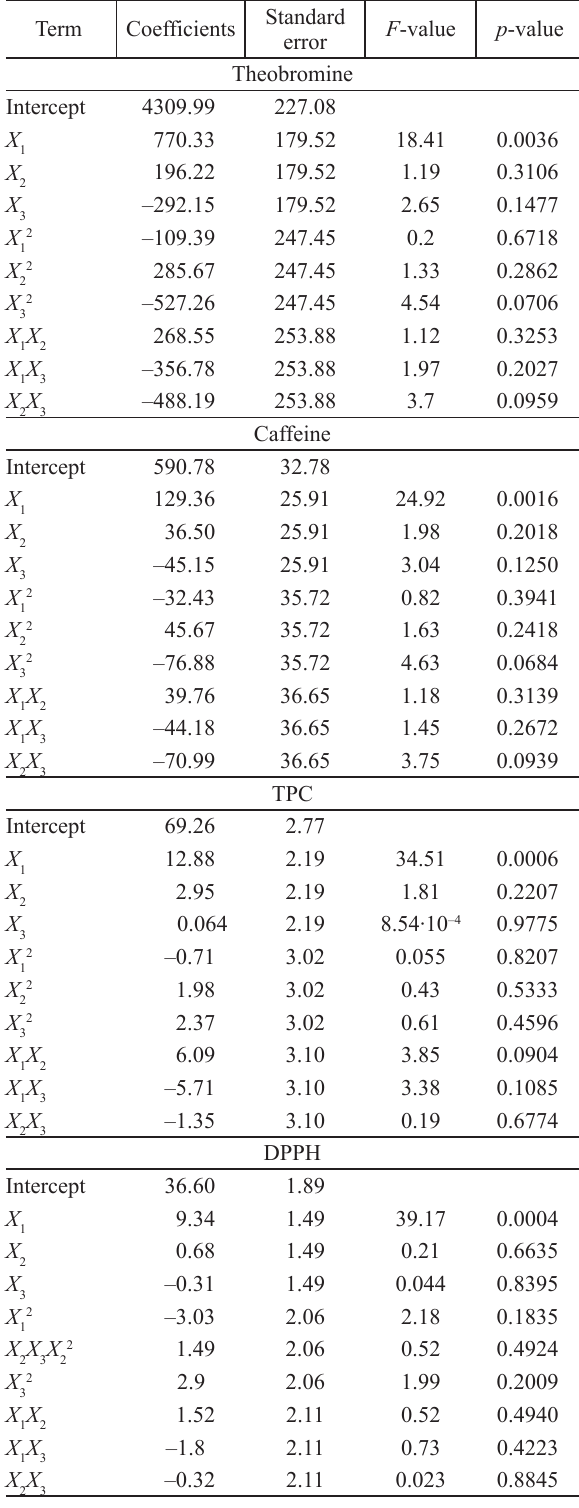
Table 5 – Analysis of variance (ANOVA) for the re­ sponse surface quadratic models Sum of Source